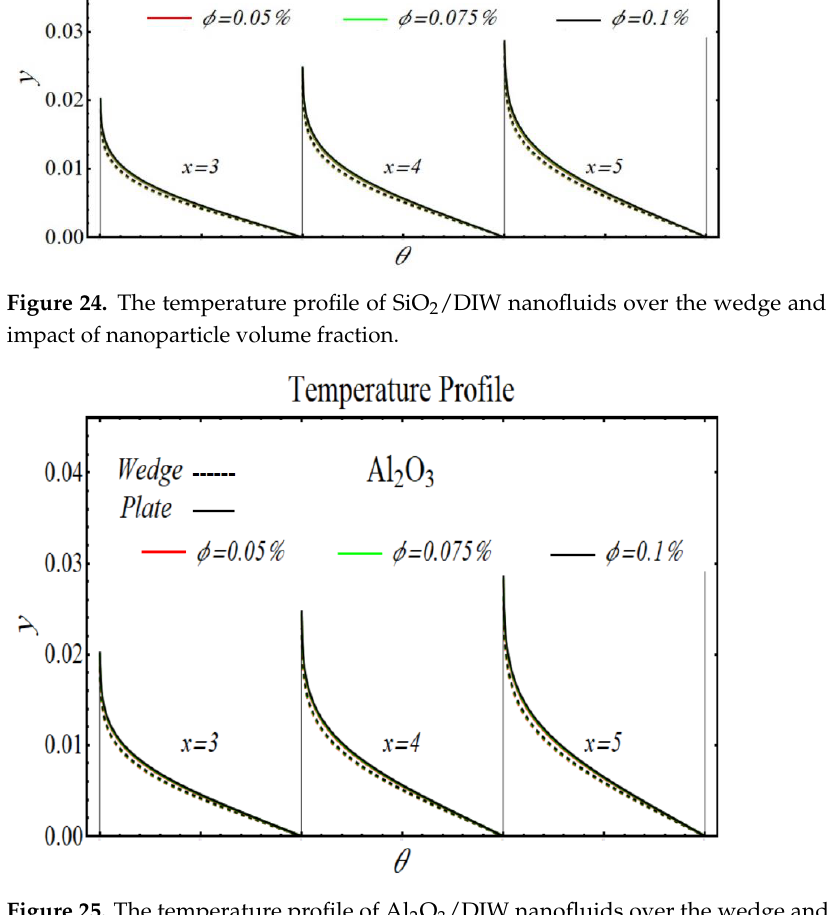
Figure 27. The temperature profile of PEG-GnP/DIW nanofluids over the wedge and plate under the impact of nanoparticle volume fraction. Table 9. Momentum boundary layer thickness 10